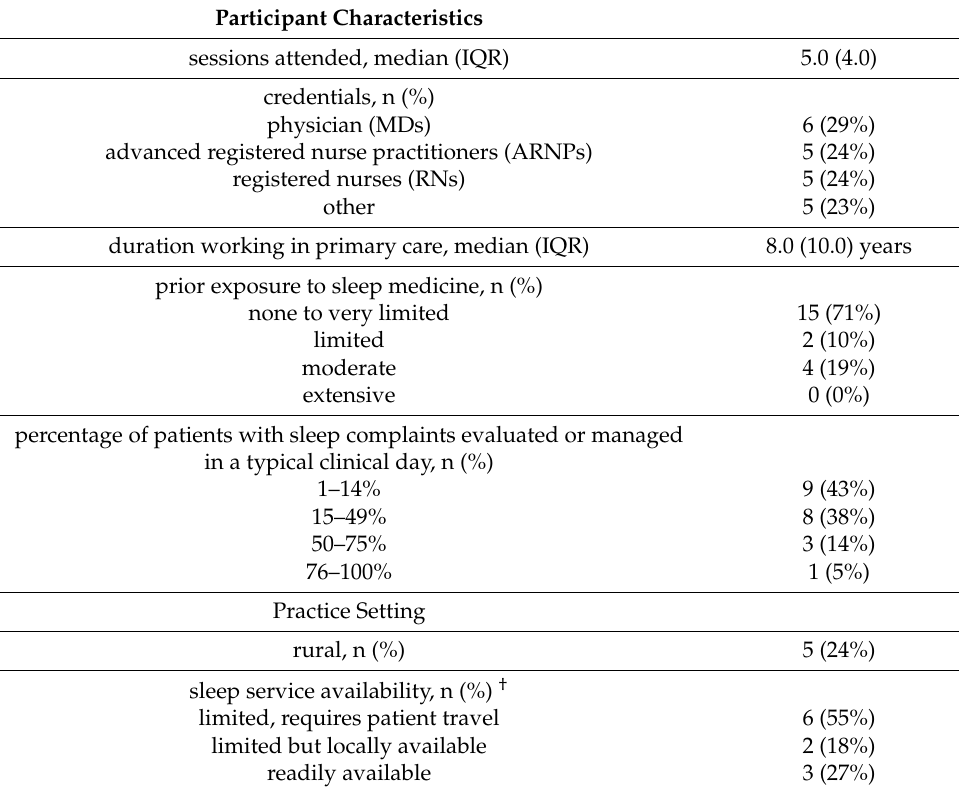
Table 1. Sleep VA-ECHO Primary Care Team Member Characteristics, N =